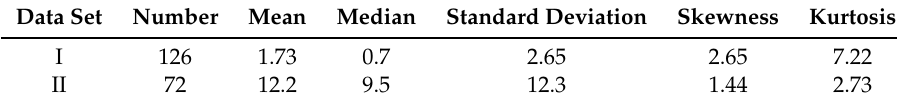
Table 7. First statistical approaches of Data sets I and II.